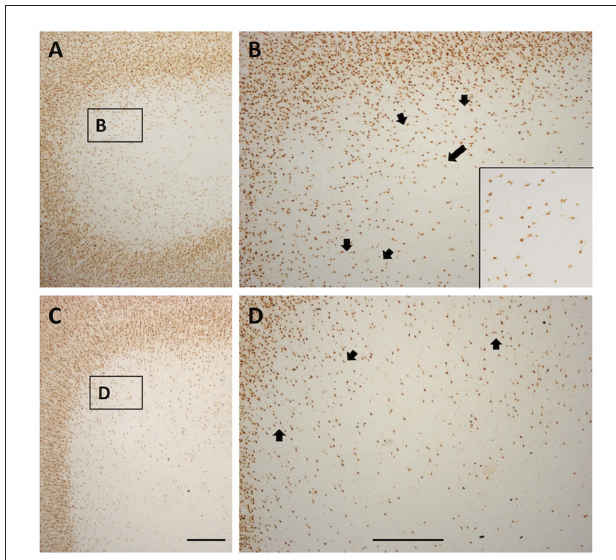
FIGURE 8 | Photomicrographs from a TE ( A and higher magnification B ) and SFG gyral region ( C and higher magnification D ). Both show a quasi-circular pattern, with scattered WMNs around the perimeter of cell-free gaps. Short arrows in (B,D) indicate several of the circular, cell-free gaps. Long arrow in (B) points to the boxed region shown at higher magnification in the inset at lower right. Boxes in (A,C) correspond to higher magnification views in (B,D) . In (A) , lateral is to the left, and in (C) , medial is to the left. Scale bars = 500 µ